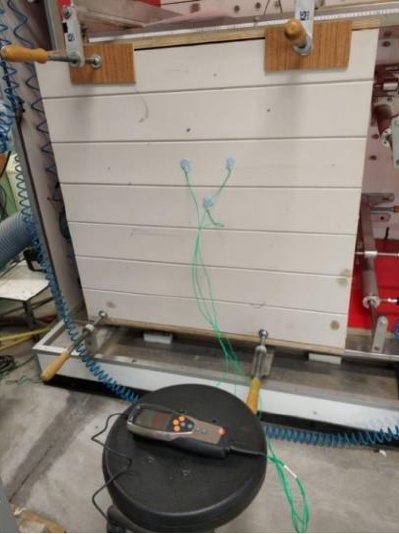
Figure 4. Installation of the masonry in the quality control mechanism for the measurement of thermal permeability using the TESTO 635-2 heat flux measuring apparatus. Equation (1): thermal